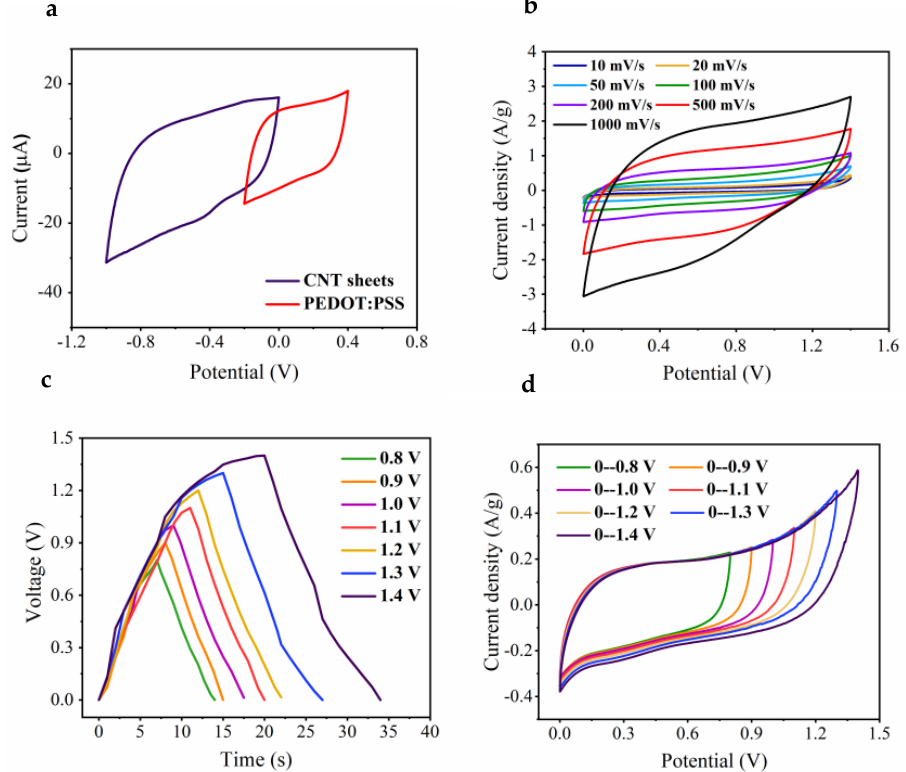
Figure 7. ( a ) Comparative cyclic voltammograms of PEDOT:PSS (+PEG) coated and CNT sheets wrapped cotton steel yarn electrodes obtained in a three-electrode system in 0.1 M PBS aqueous solution at a scan rate of 50 mV s − 1 . ( b ) CV curves tested over different voltages from 0.8 to 1.4 V at a scan rate of 50 mV s − 1 . ( c ) Galvanostatic charge-discharge curves obtained over different voltages from 0.8 to 1.4 V at a current density of 0.5 A g − 1 . ( d ) CV curves of an optimized asymmetric supercapacitor at scan rates ranging from 10 to 1000 mV s − 1